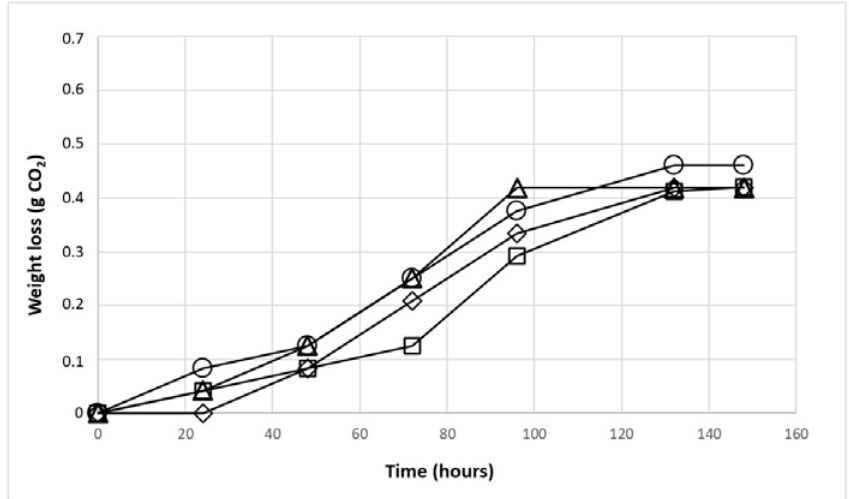
Figure 2. Fermentation kinetics (depicted as cumulative weight loss) of yeasts isolated from apricot fruits growing in malt wort (W). Circle: Pichia kudriavzevii L1; diamond: Hanseniaspora uvarum L2; triangle: H. pseudoguilliermondii L3; square: H. clermontiae L4. Data are means ± SD of three independent replicates. Where not visible, error bars lie below the symbols.